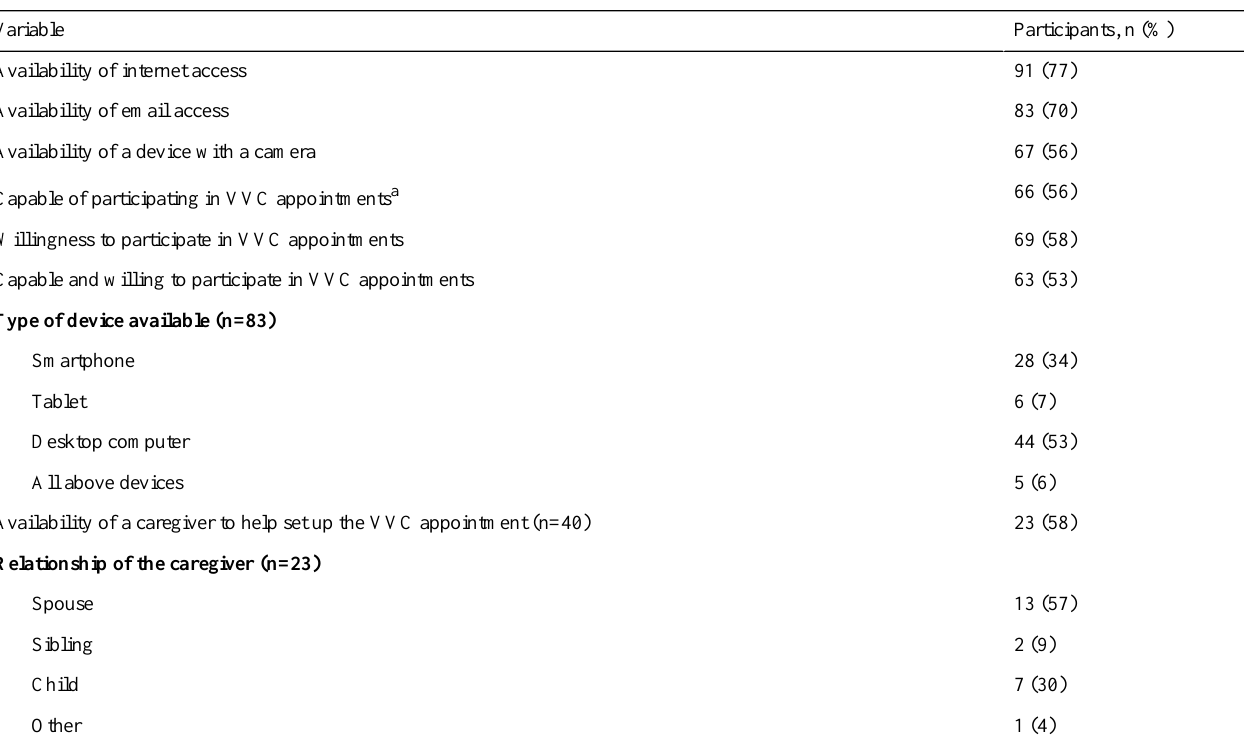
Table 2. Details on capability and willingness to participate in a VA Video Connect (VVC) appointment (N=118).